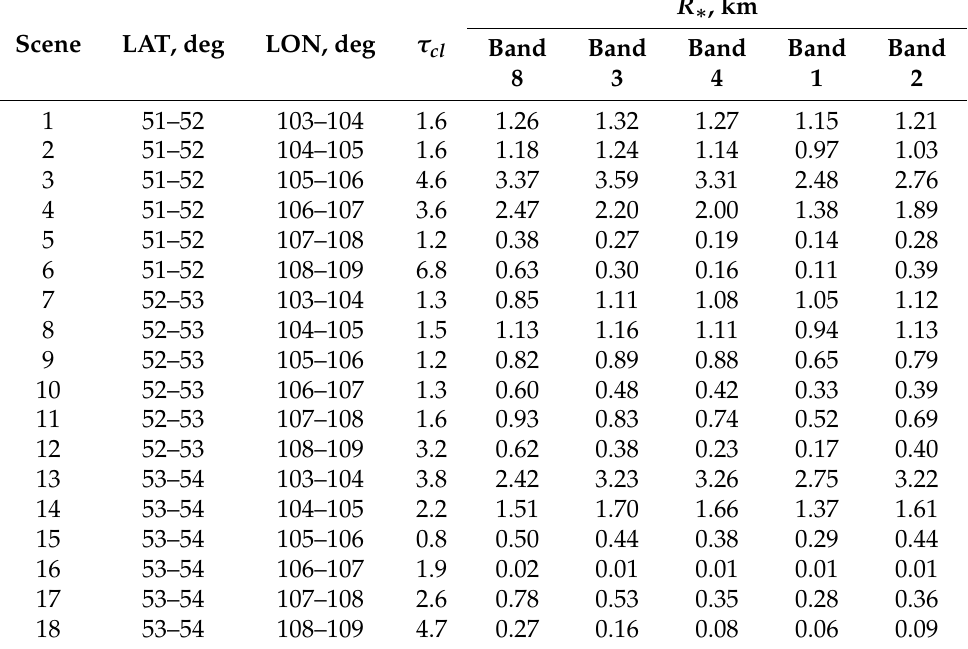
Table 4. Values of R ∗ for five MODIS bands and 18 scenes on 7 July